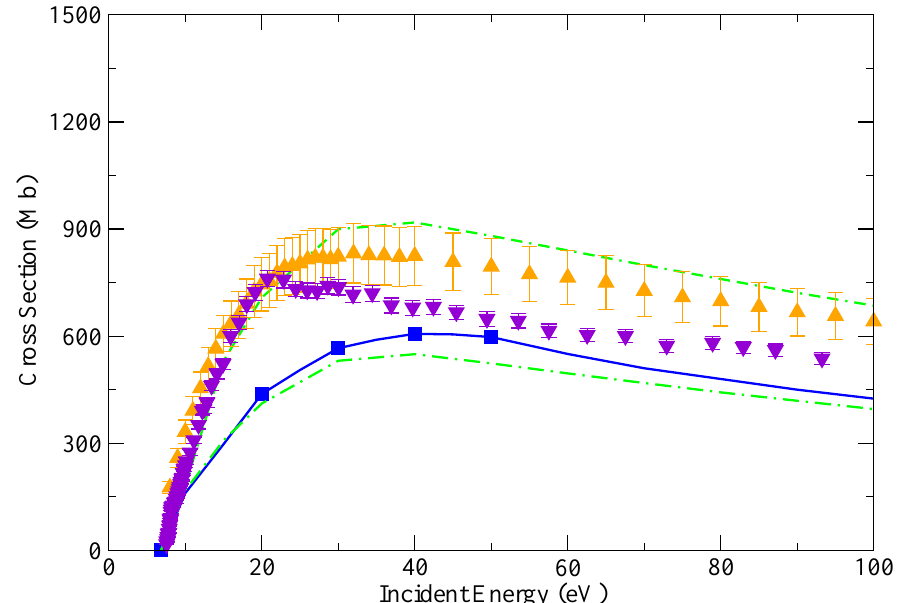
Figure 8. Electron-impact ionization of Pb. Solid line with squares (blue): total TDCC direct ionization cross section with a polarization potential, dot–dash line (green): total CCC direct ionization cross section [9] with a polarization potential, dot–dash–dash line (green): total CCC direct ionization cross section with a polarization potential plus R-matrix B-spline indirect ionization cross section [9], up triangles (orange): crossed-beams measurements [10]. down triangles (violet): crossed-beams measurements [11] (1.0 Mb = 1.0 × 10 − 18 cm 2